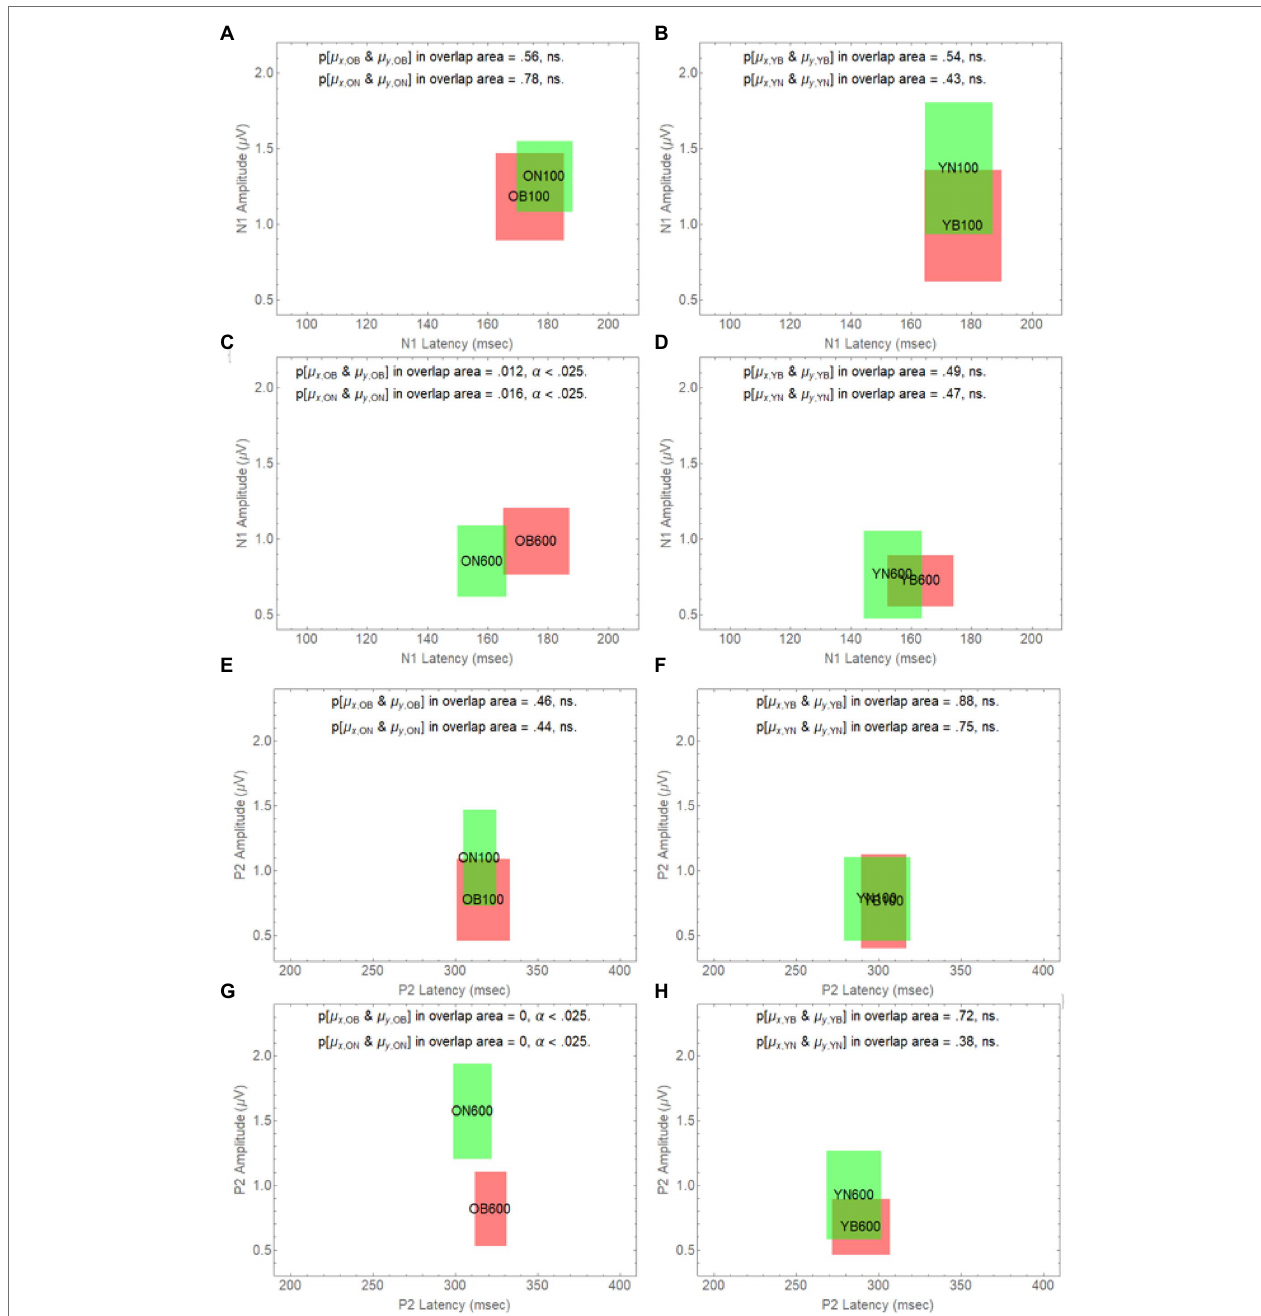
FIGURE 6 | Degree of overlap between Noise and Babble for Onset Delays of 100 and 600 ms for N1 and P2 waves in Younger and Older Adults. The overlap between masker condition (N vs. B) is depicted in separate panels (A-H) for all possible combinations of delay (100 vs. 600) and age (O vs. Y), for the two waveform components (N1 and